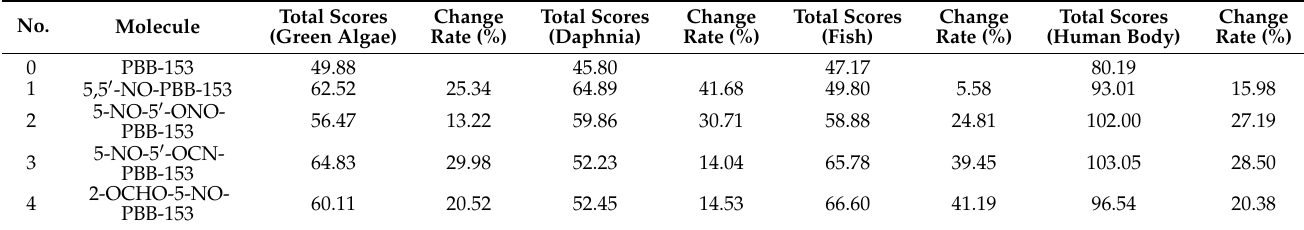
Table 7. Total scores of PBB-153 molecular docking with food chain degrading enzyme before and after modification. No.